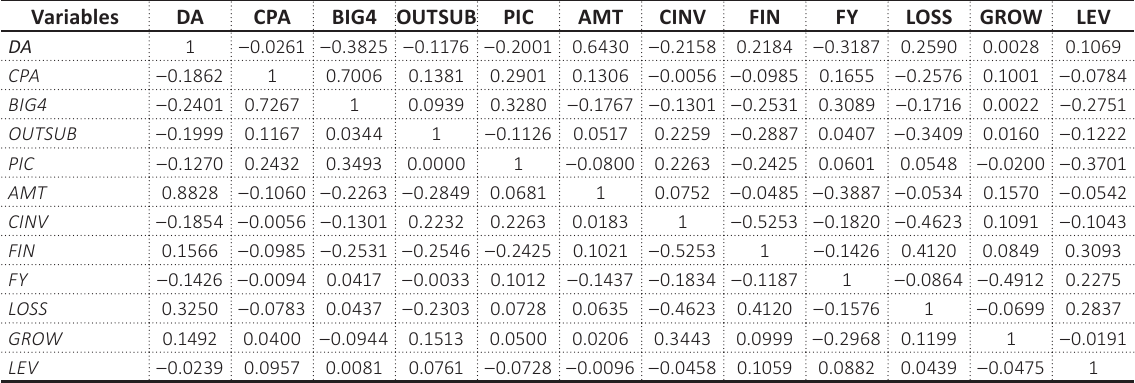
Table 5. Person correlation coefficient and Spearman rank correlation coefficient